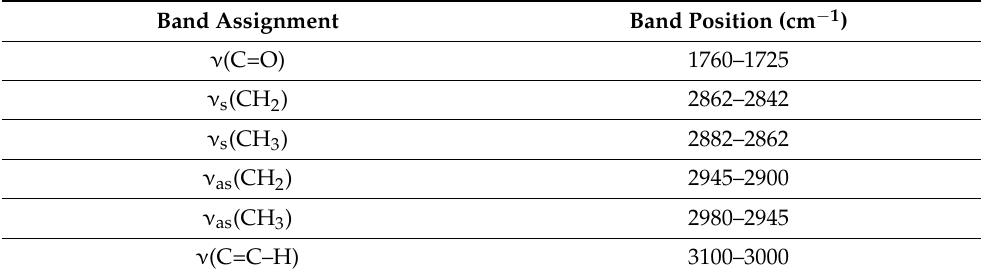
Table 3. Band positions and assignments in the SR-FTIR spectroscopy spectra ( ν = stretching vibration; s = symmetric; as =